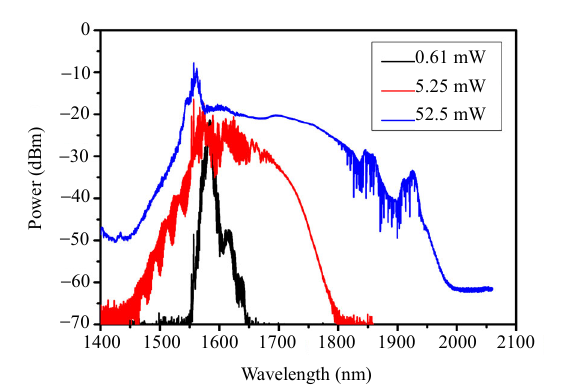
Fig. 4 Spectral distribution after the ZBLAN fiber for different average output powers.